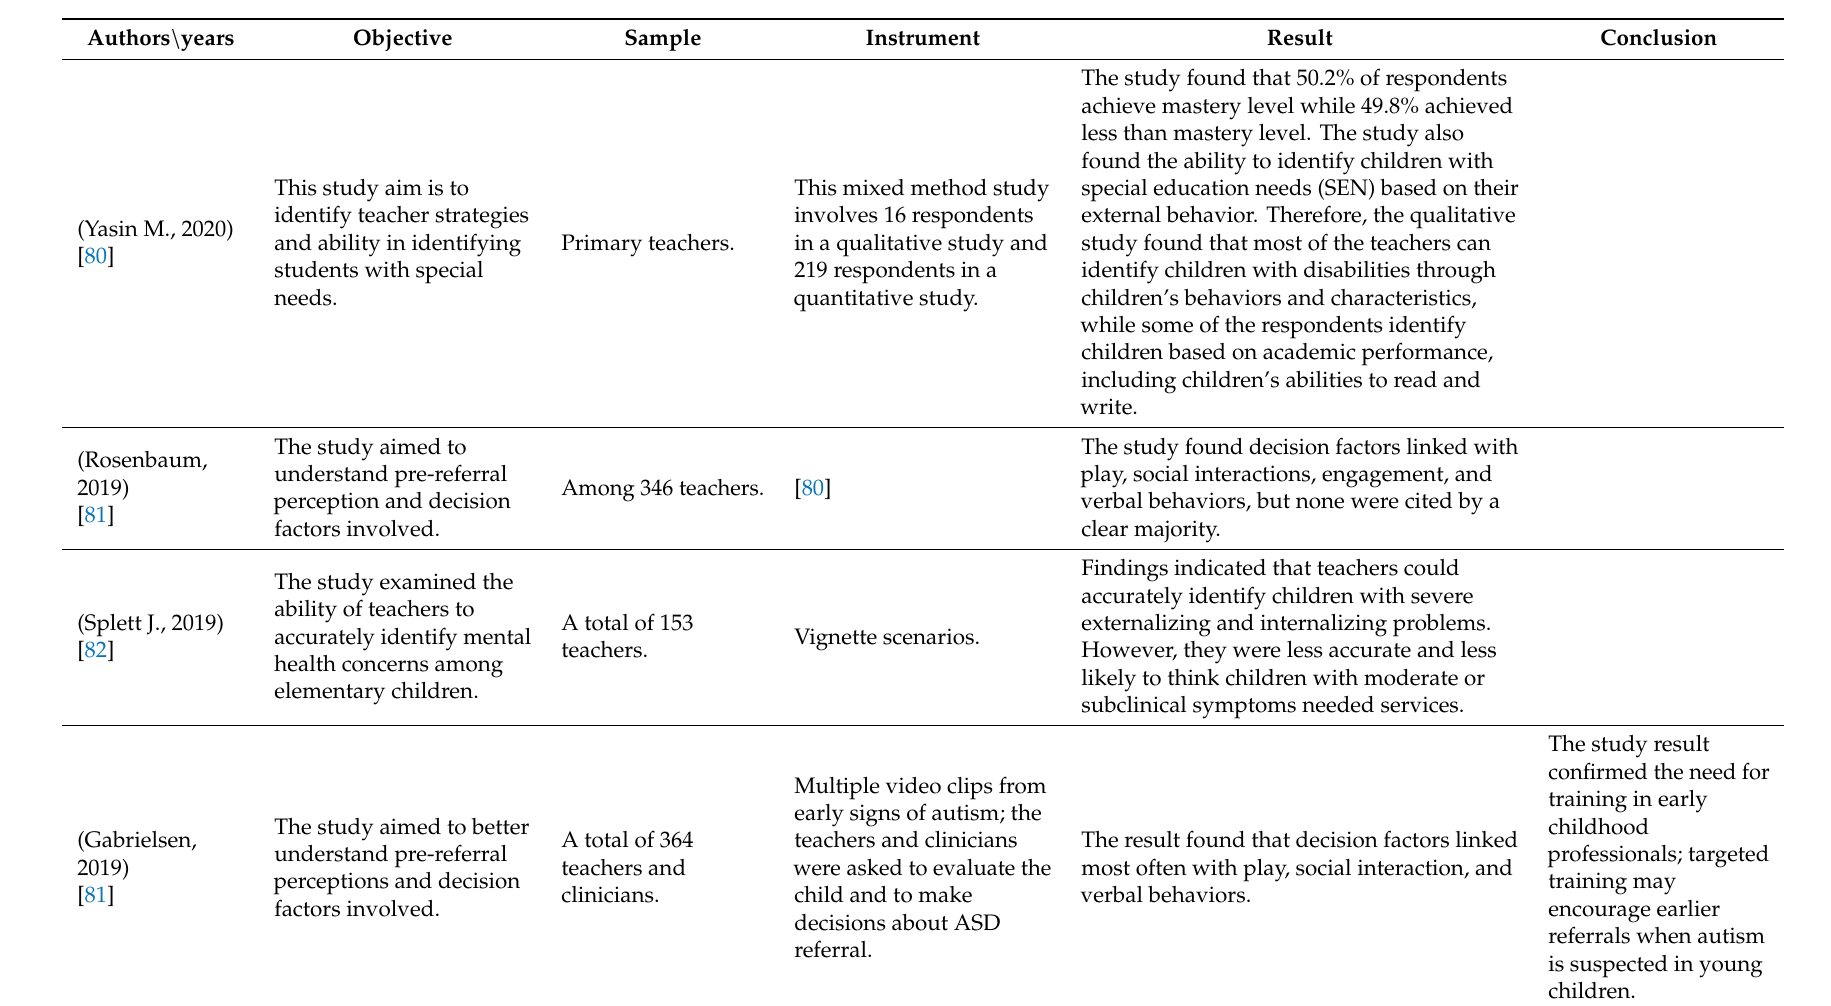
Table 3. Summary studies of identification skills about